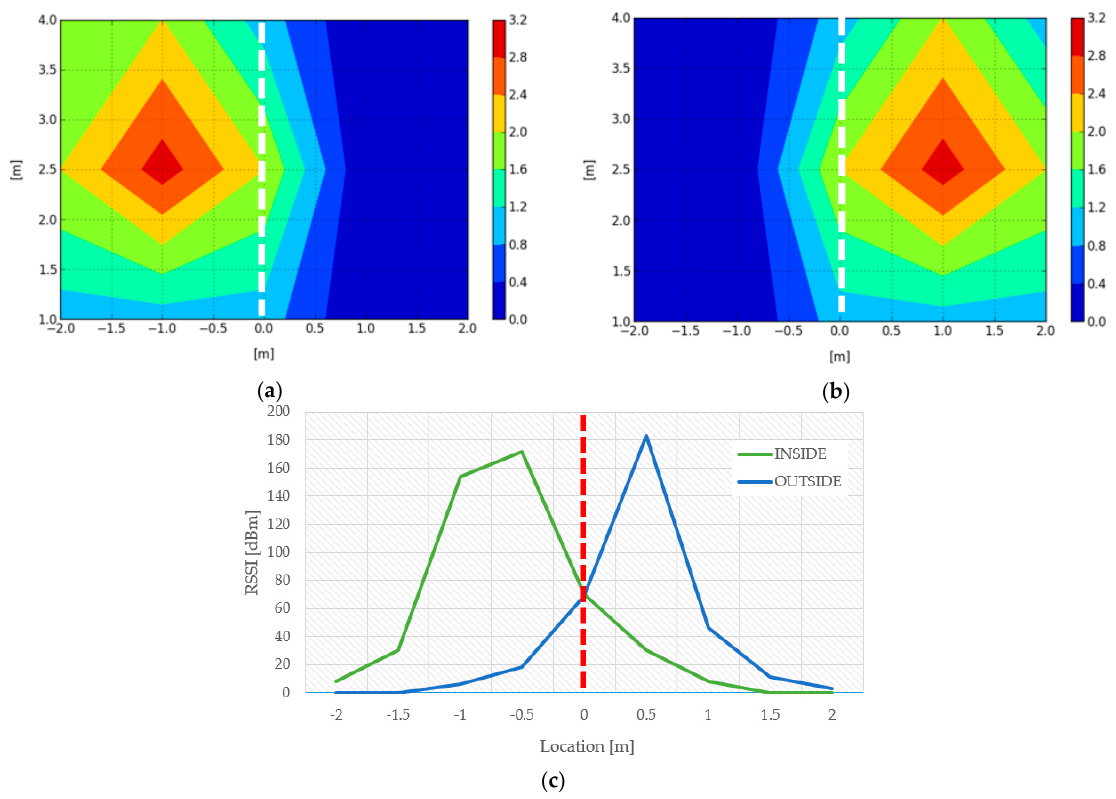
Figure 11. Signal strength between ( a ) inside and ( b ) outside low frequency (LF) transmitters and ( c ) comparison of signal strength.